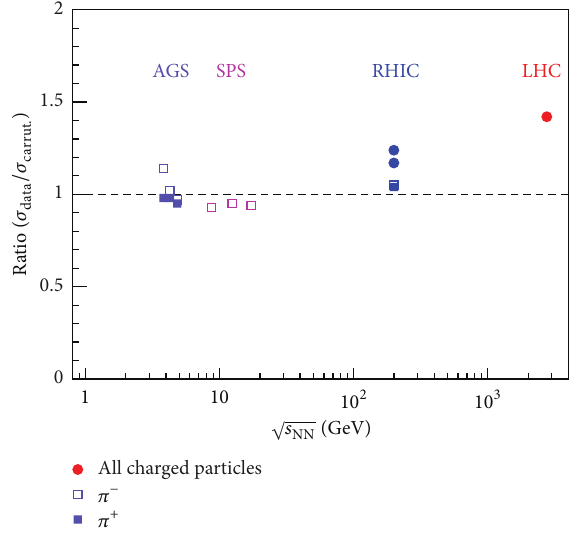
Figure 17: The ratio of the widths of the data to the width obtained by fitting Landau-Carruthers function to the charged particle multiplicity density, as a function of collision